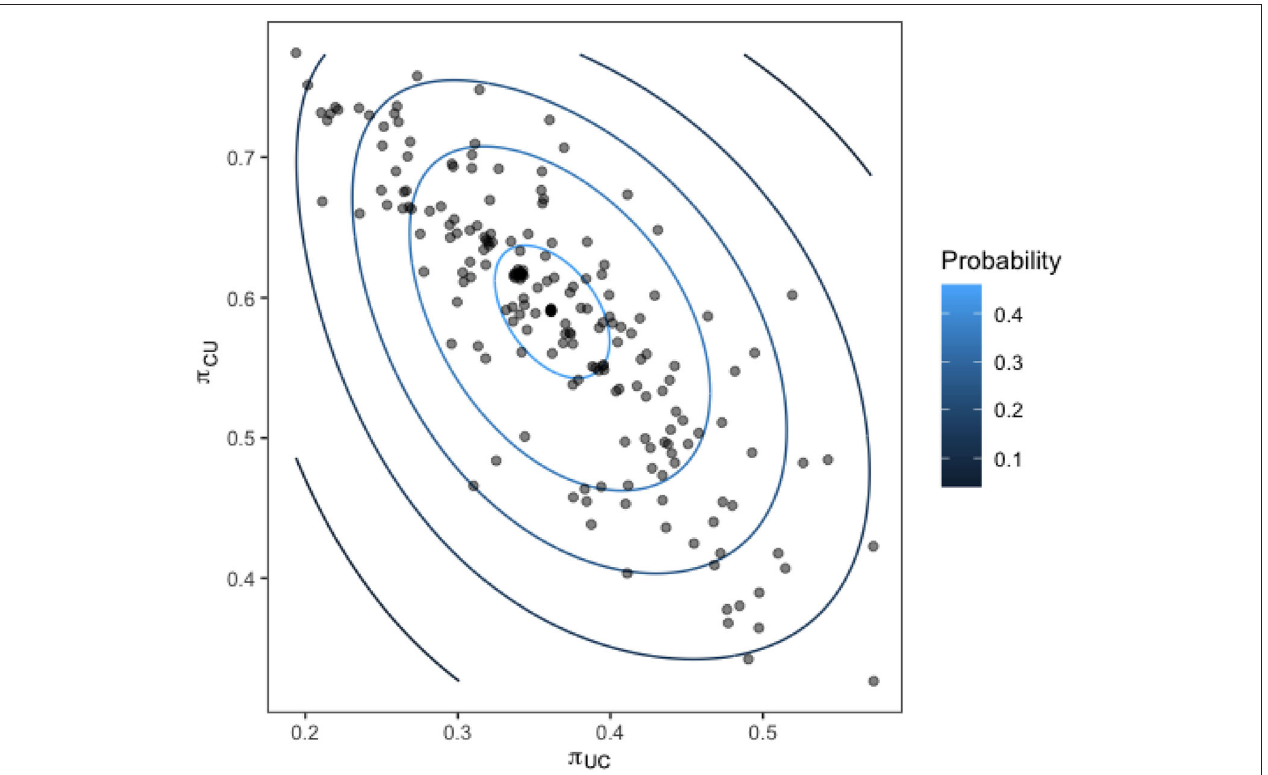
FIGURE 9 | Transition probabilities for each bird in the flock from a state of being colonized to uncolonized (y-axis) against the transition probability from uncolonized to colonized (x-axis). Contours show the fit of a multivariate normal distribution to the